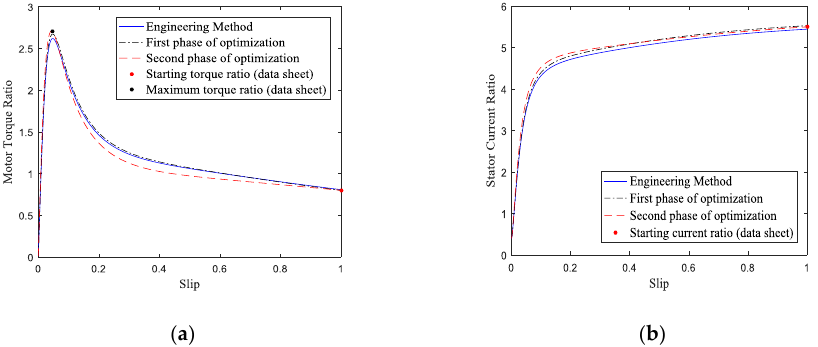
Figure 3. Characteristics of the induction motor number 1 (DAZO-1569-8/10): ( a ) Torque-slip, ( b ) Current-slip.